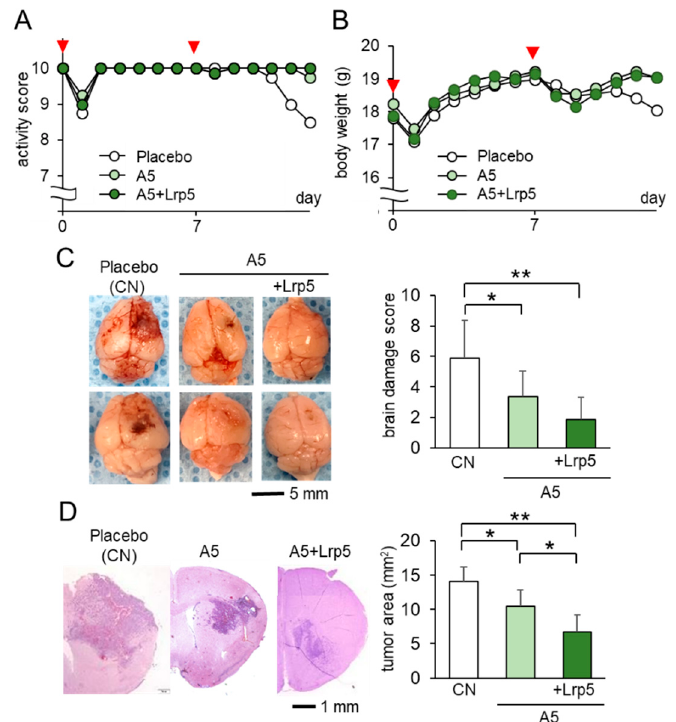
Figure 3. Suppression of the growth of brain tumors by the co-injection of Lrp5-overexpressed osteocytes in C57BL/6 mice ( N = 8 per group). Of note, CN = control. The single and double asterisks indicate p < 0.05 and p < 0.01, respectively. The error bar indicates a standard deviation. ( A , B ) Activity score and body weight for 2 weeks. The red arrowheads indicate osteocyte injections. ( C ) Representative images of the whole brain with the brain damage score. ( D ) Histological images and the comparison of tumor areas in the coronal section.